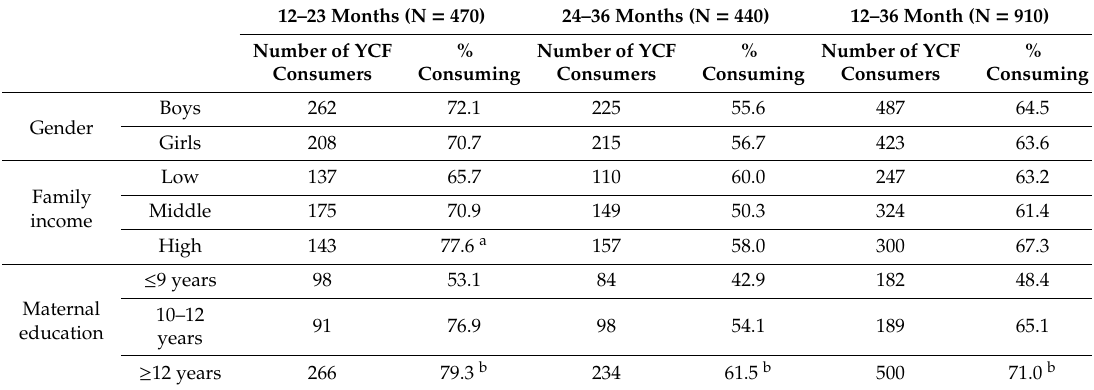
Table 1. Percent of children consuming young children formula (YCF) in the study population.